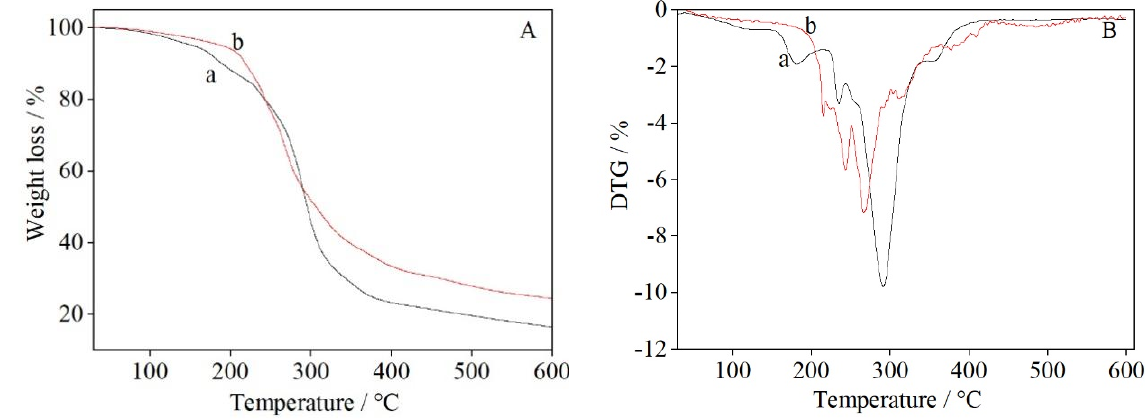
Figure 5. TG ( A ) and DTG ( B ) traces of ( a ) the control UF, and ( b ) UF/3% CuSO 4 .